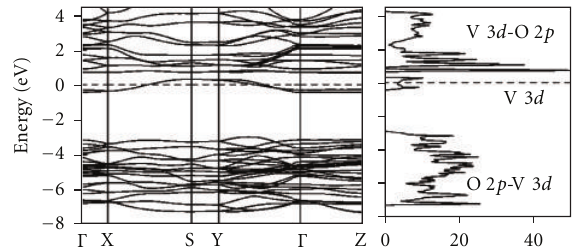
Figure 26: LDA band structure and the total DOS calculated for α (cid:2) -NaV 2 O 5